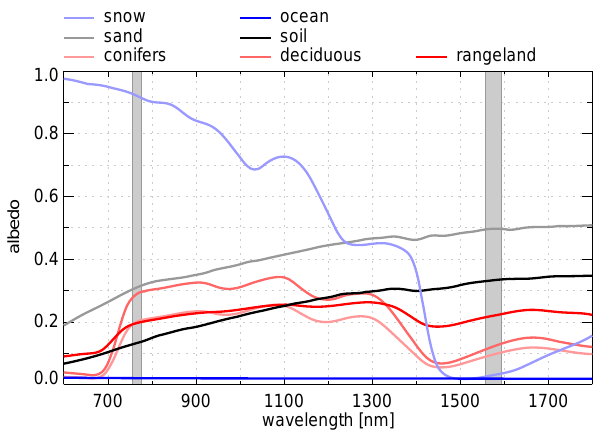
Fig. 5. Spectral albedos of different natural surface types. Repro- duced from the ASTER Spectral Library through the courtesy of the Jet Propulsion Laboratory, California Institute of Technology, Pasadena, California (©1999, California Institute of Technology) and the Digital Spectral Library 06 of the US Geological Survey. spectral signatures which makes them distinguishable from other weighting functions. These parameters are cloud top